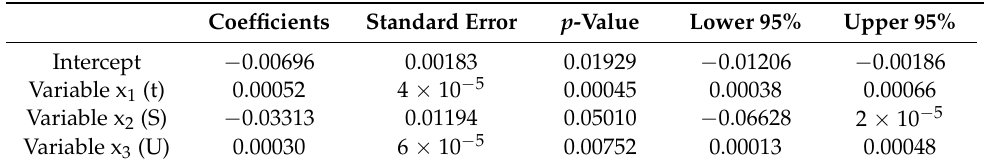
Table 4. ANOVA analysis for the coefficients of Equation (2).